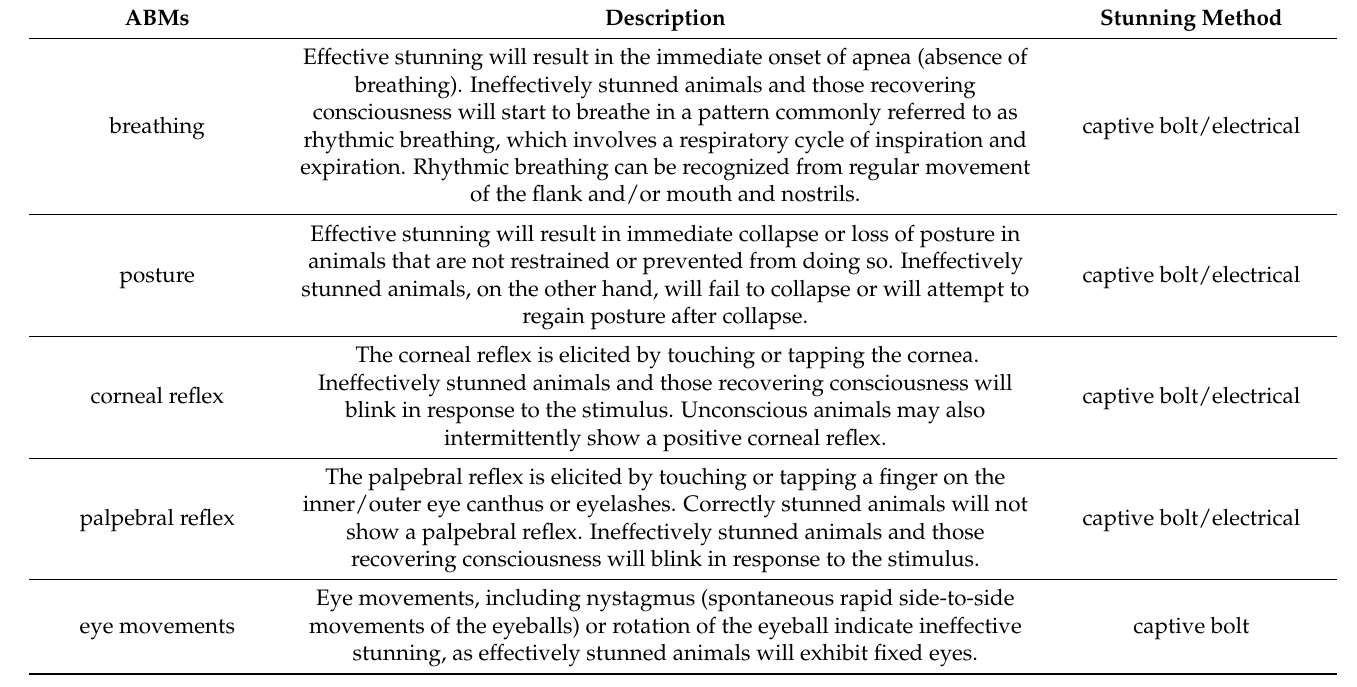
Table 1. Animal-based measures (ABMs) used to assess proper electrical and mechanical stunning in sheep